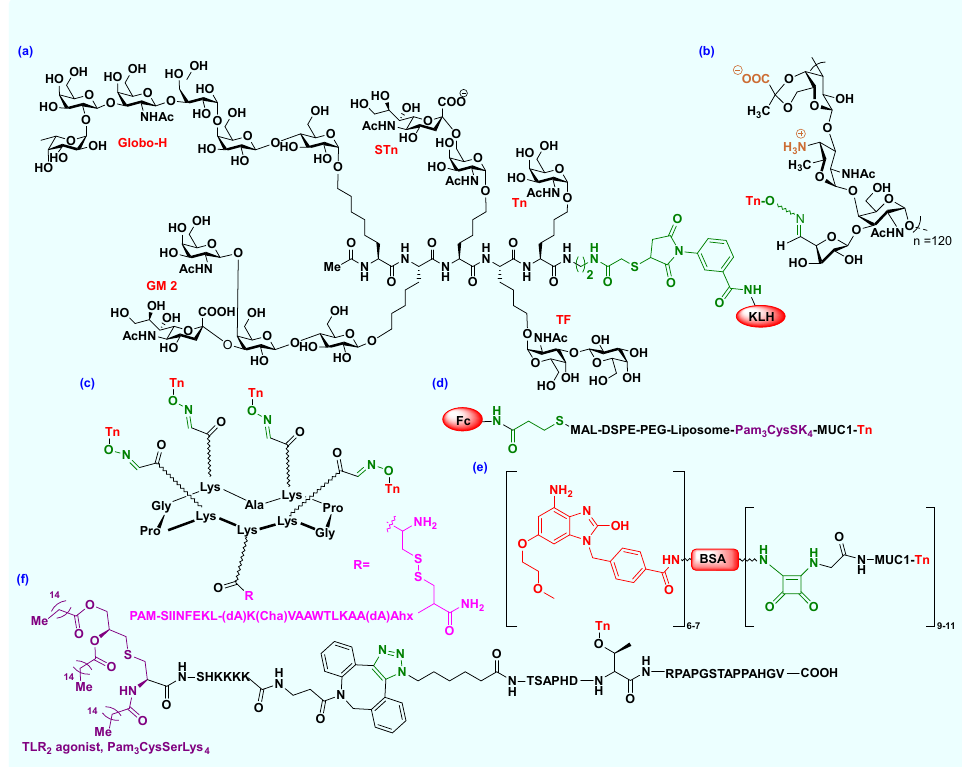
Figure 4. Fully synthetic or semi-synthetic cancer vaccine constructs: ( a ) a multicomponent vaccine containing different TACAs, a peptide backbone, and a carrier protein (KLH); ( b ) Tn antigen conju- gated with PS A1 vaccine without any linker; ( c ) a cyclo-decapeptide platform containing clustered Tn antigen analogs, MHC-II epitope, and TLR2 adjuvant; ( d ) liposomal Fc domain conjugated to a MUC1 based cancer vaccine; ( e ) synthesis of TLR7a-BSA-MUC1 vaccine using squaric acid monoamide linker; ( f ) utilization of click chemistry for the synthesis of Pam 3 CysSK 4 -DBCO-MUC1 VNTR-TACA. Abbreviation: dA, D-alanine; Cha, cyclohexyl alanine; Ahx, L-2-aminohexanoic acid; PAM, palmitic acid; Pam3Cys, S-((R)-2,3-bis(palmitoyloxy)propyl)-N-palmitoyl-L-cysteine.